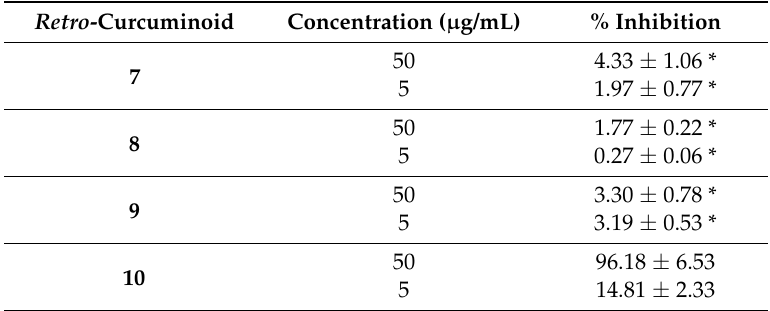
Table 4. Inhibition of lipid peroxidation of retro -curcuminoids 7 , 8 , 9 , and 10 in rat brain. Retro